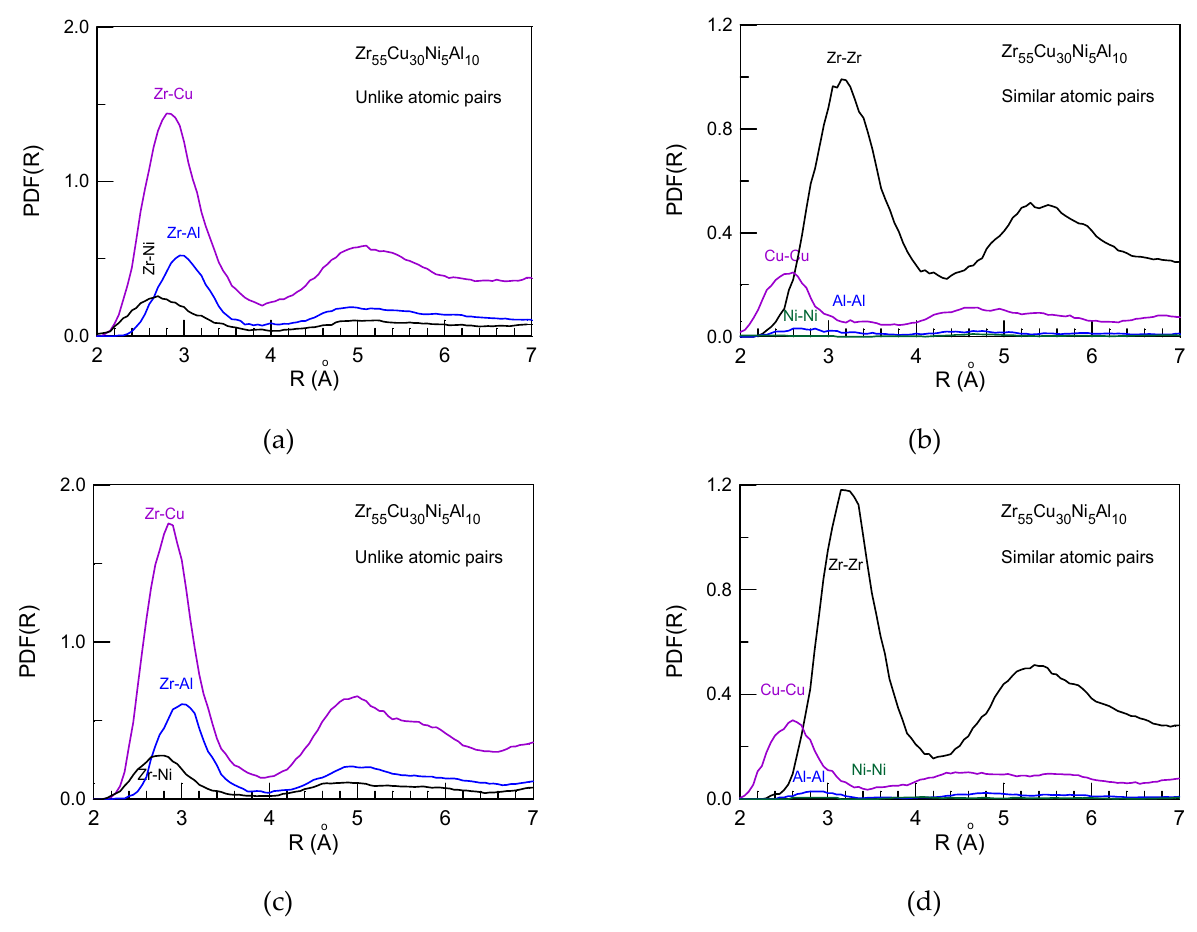
Figure 11. Partial PDF(R) functions obtained by computer simulation at 1400 K (liquid state) ( a , b ) and 500 K (glass state) ( c , d ). Reproduced from Ref. [152] with permission of Elsevier.